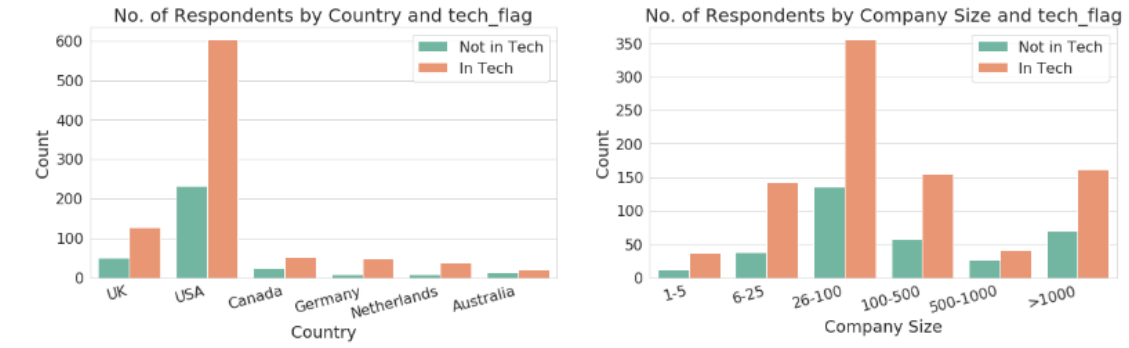
Figure 3: Respondents by countries with tech flag and company size orange